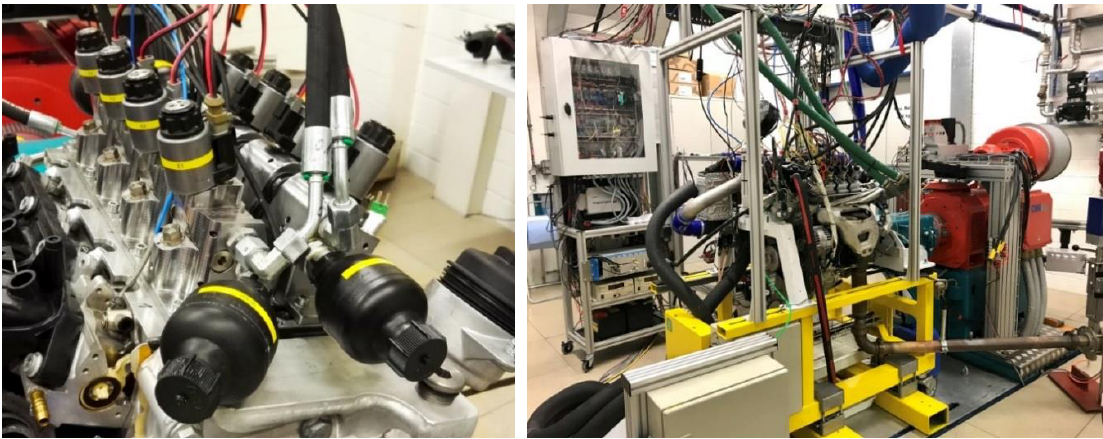
Figure 1. Electro hydraulic valve train on the VW EA111 short block (left), engine on the test bench (right).